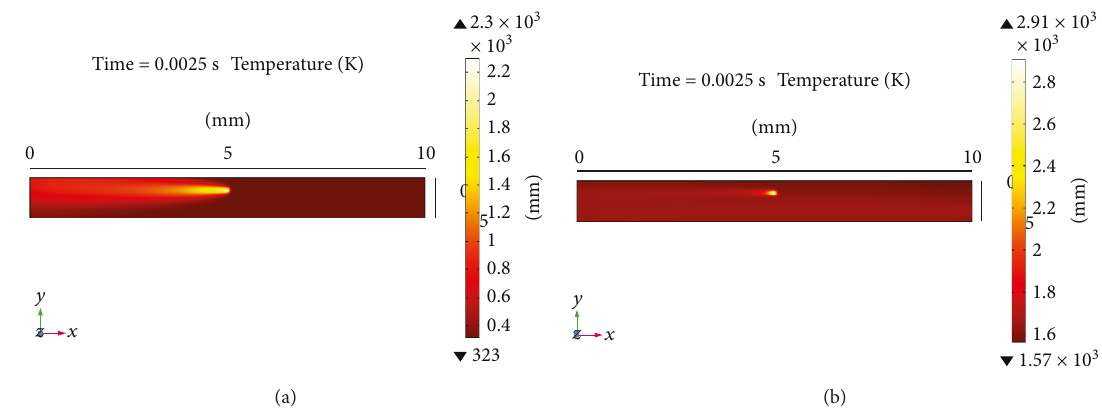
Figure 12: The distribution of the temperature fi eld corresponding to the midpoint position of the fi rst scanning track in each layer: (a) fi rst layer and (b) fi fth